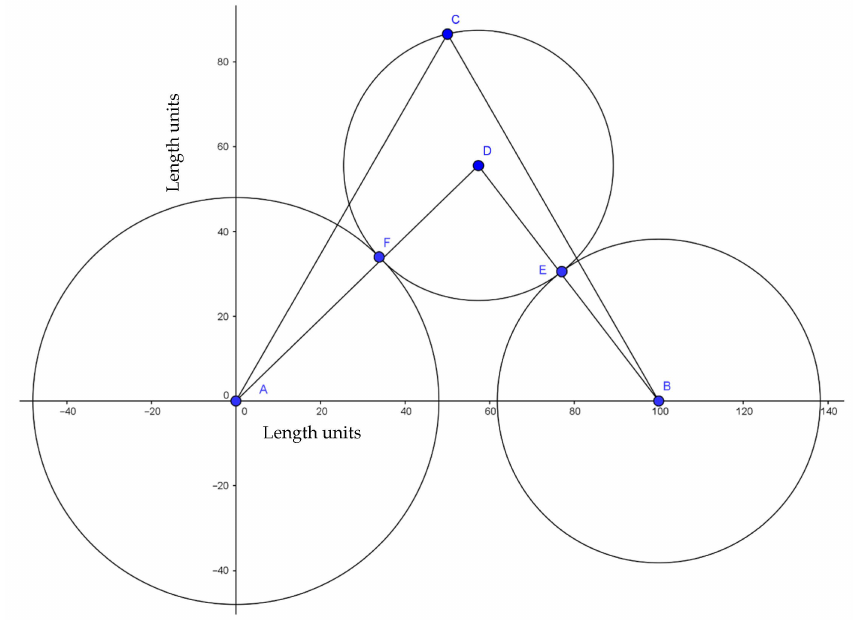
Figure 8. Scheme of the acoustic emission delays for locating the